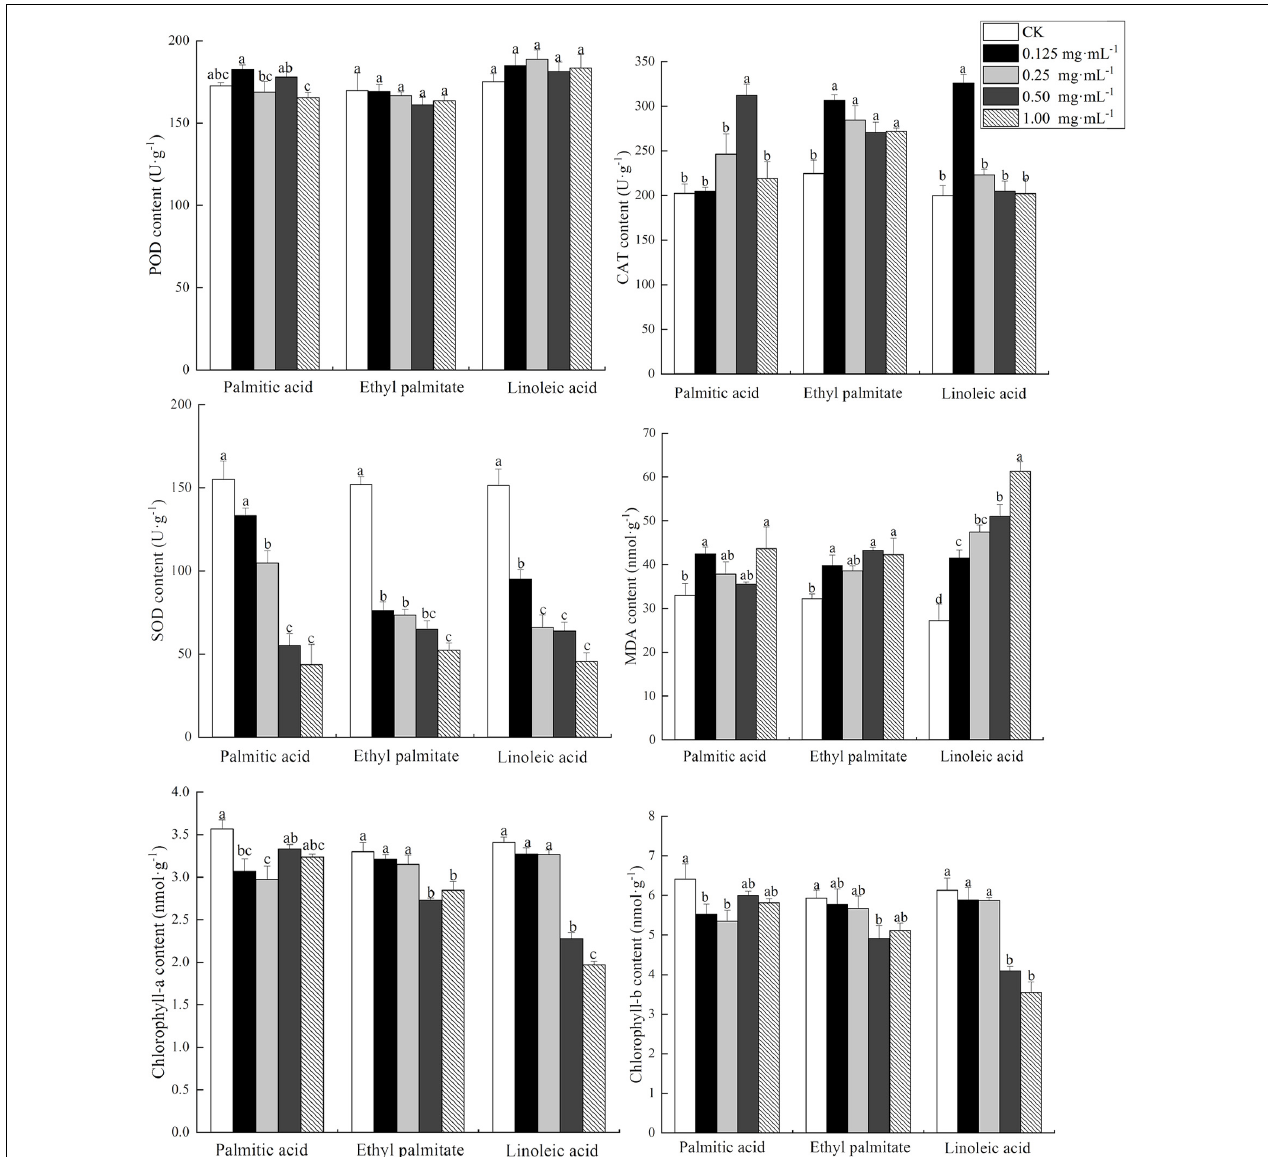
FIGURE 3 | Antioxidant enzyme and chlorophyll properties of fresh Lolium multiflorum seedlings affected by three allelopathic substances. SOD, superoxide dismutase; CAT, catalase; POD, peroxidase; MDA, malondialdehyde. Different letters signify significant differences among concentrations of a particular compound at P <